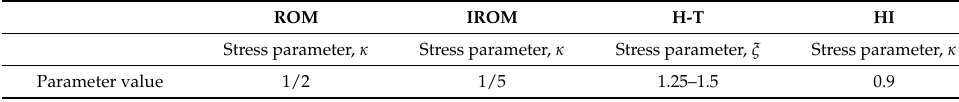
Table 8. Stress parameter for modified micromechanical